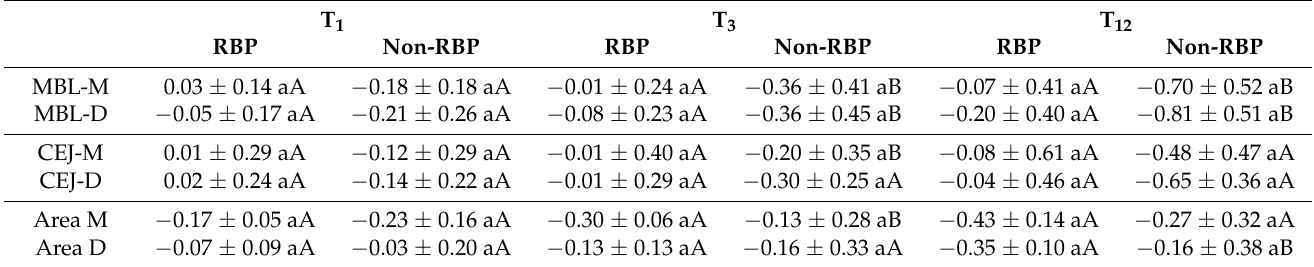
Table 2. Mean ± SD values of the evaluated measures at 1, 3 and 12 months. Different letters represent statistically significant differences in the same horizontal row (capital letters among times) or in the same column (small letters for RBP/non-RBP). p value was set at 0.05. T 1 T 3